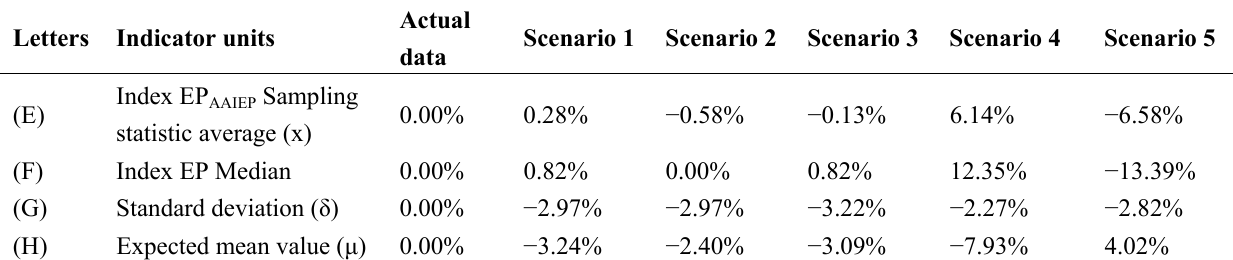
Table 11. Statistical analysis indicator and scenarios: percentage increase.